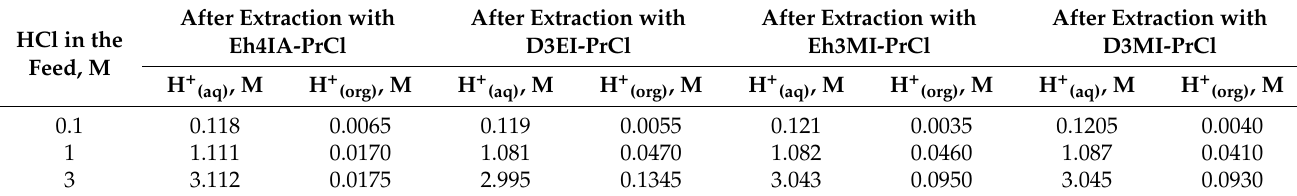
Table 3. H + co-extraction into the organic phase containing 0.005 M Eh4IA-PrCl, D3EI-PrCl, Eh3MI-PrCl, and D3MI-PrCl (A/O = 1, feed: 2.5 × 10 − 3 M Pd(II) in 0.1–3 M HCl). HCl in the Feed,